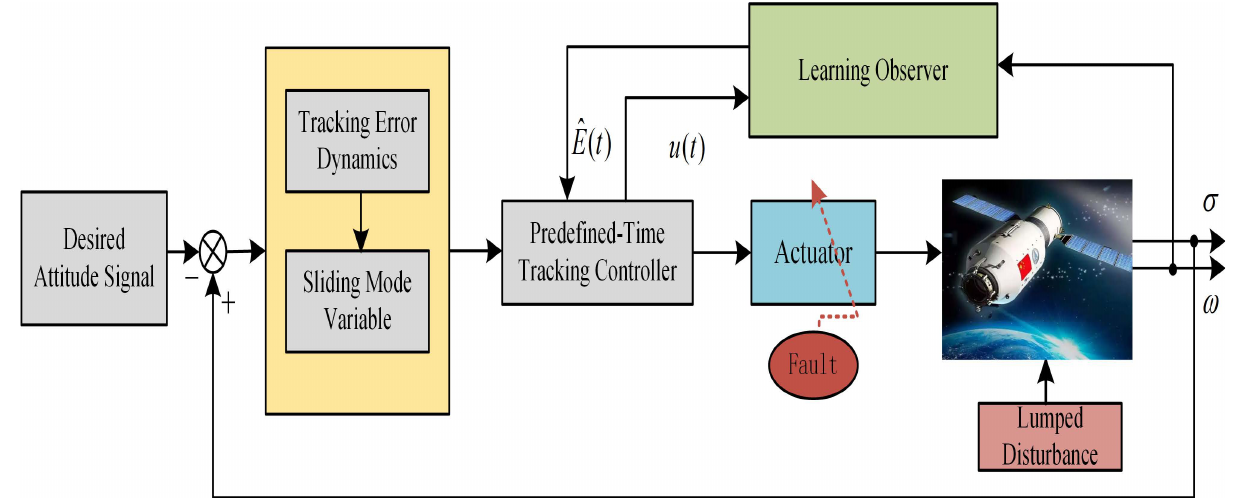
Figure 1. The structure of the observer-based predefined-time attitude control